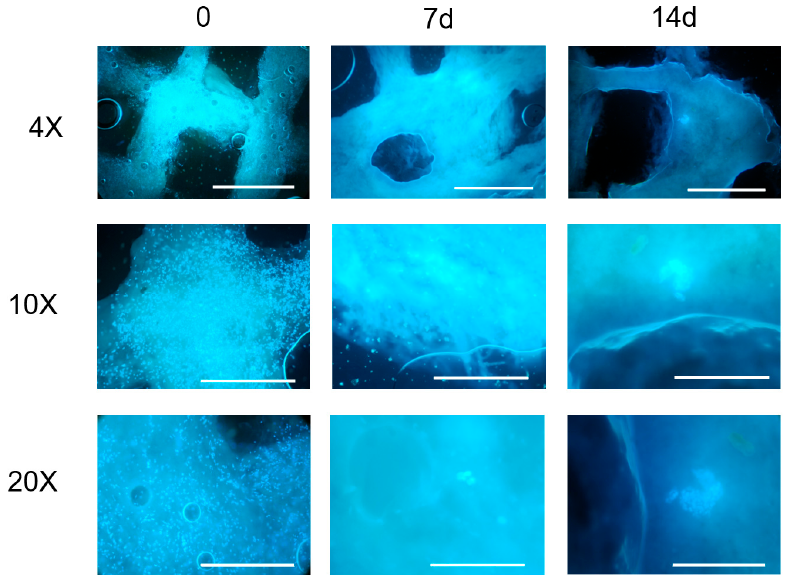
Figure 4. Images from fluorescence microscope (Olympus CX41) at different magnifications (4×, 10×, 20×) of the constructs printed with an initial concentration of 6 × 10 6 UMR-106 cells/mL at different time points. Nuclei stained by Hoechst 33342. Scale bar 1 mm (4×), 500 μ m (10×), 250 μ m (20×). time points. Nuclei stained by Hoechst 33342. Scale bar 1 mm (4 × ), 500 µ m (10 × ), 250 µ m (20 ×